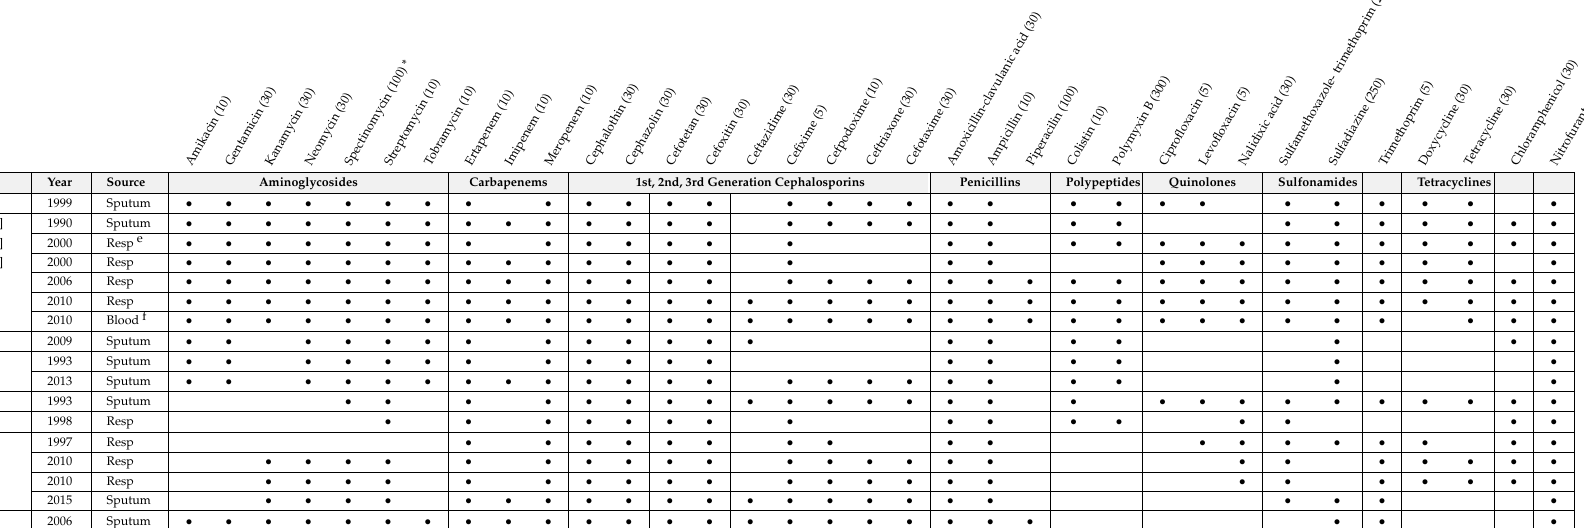
Table 1. Resistance patterns of isolates to different classes of antimicrobial